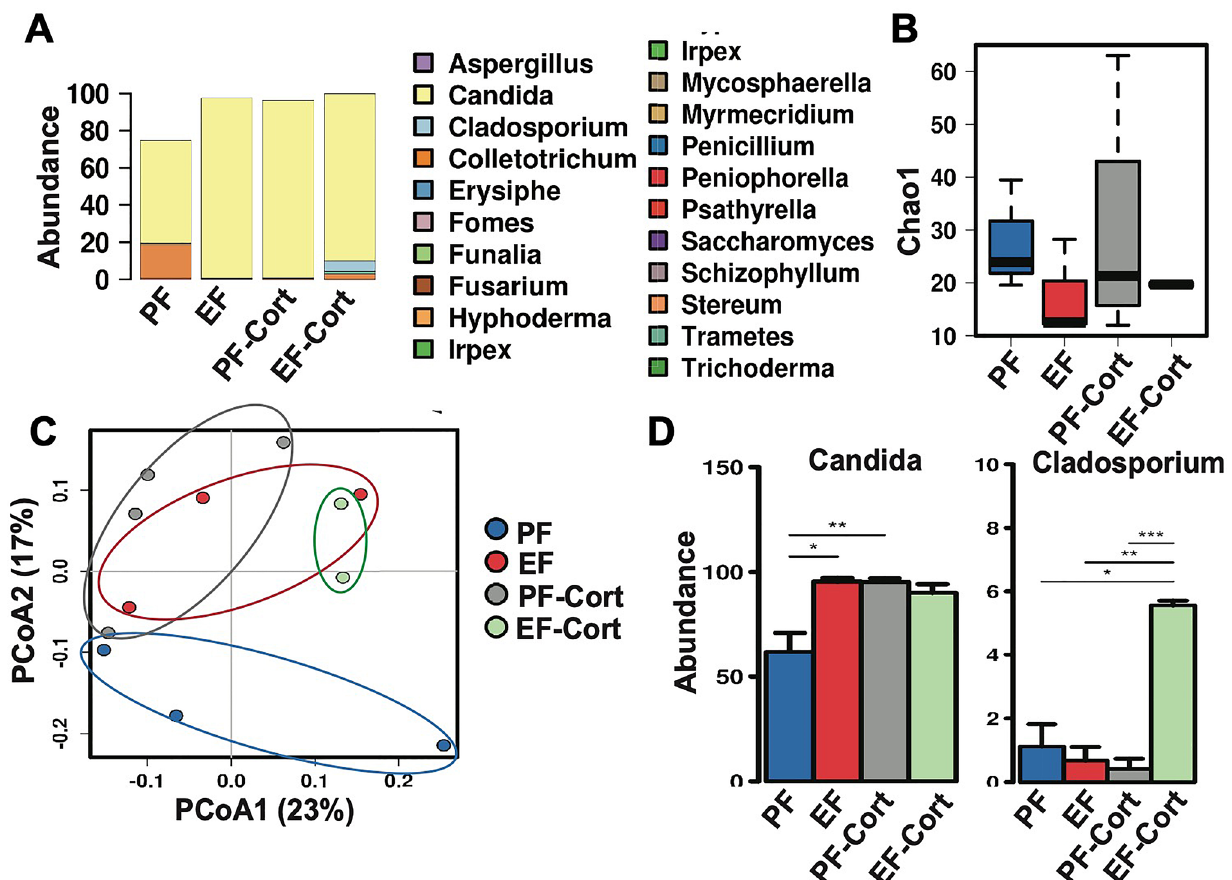
Figure 9. Corticosterone effect alcohol-induced dysbiosis of intestinal mycobiome. Adult mice were fed a liquid diet with (EF) or without (PF) ethanol for four weeks. In some groups, animals were injected with corticosterone (CORT) daily. Animals in other groups were injected with the vehicle. Analysis of data from 16S rRNA-sequencing of fecal samples from different groups of mice is presented. ( A ) Fungal phylum is displayed in each group. ( B ) Fungal α-diversity calculated by Chao1. ( C ) Principal coordinate analysis was used to visualize β-diversity in fungal populations with Jaccard dissimilarity. ( D ) Significantly altered fungal genus are displayed by ANOVA. *P < 0.05; **P < 0.01; ***P <